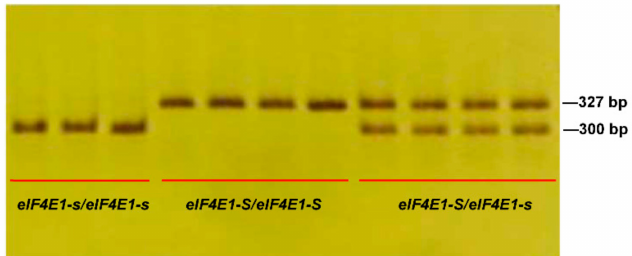
Figure 3. Detection of eIF4E1-S mutagenesis by dCAPS (derived cleaved amplified polymorphic sequence) markers. eIF4E1-s / eIF4E1-s , homozygous mutants with mutagenized eIF4E1-S